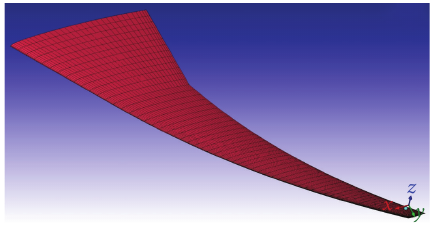
Figure 4: Surface grid of the curved wing model.